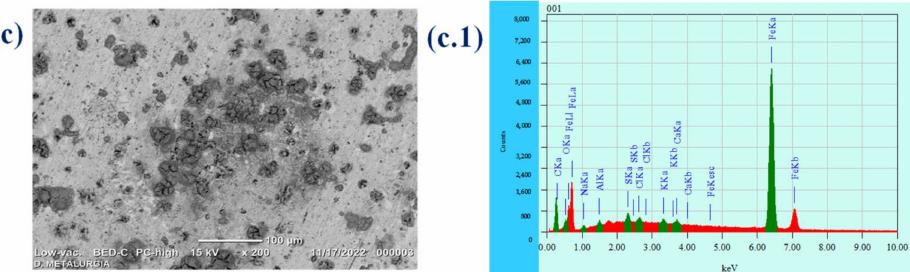
Figure 10. SEM-EDS images at 200 × of ( a , a.1 ) API 5L X70 steel with no inhibitor, ( b , b.1 ) API 5L X70